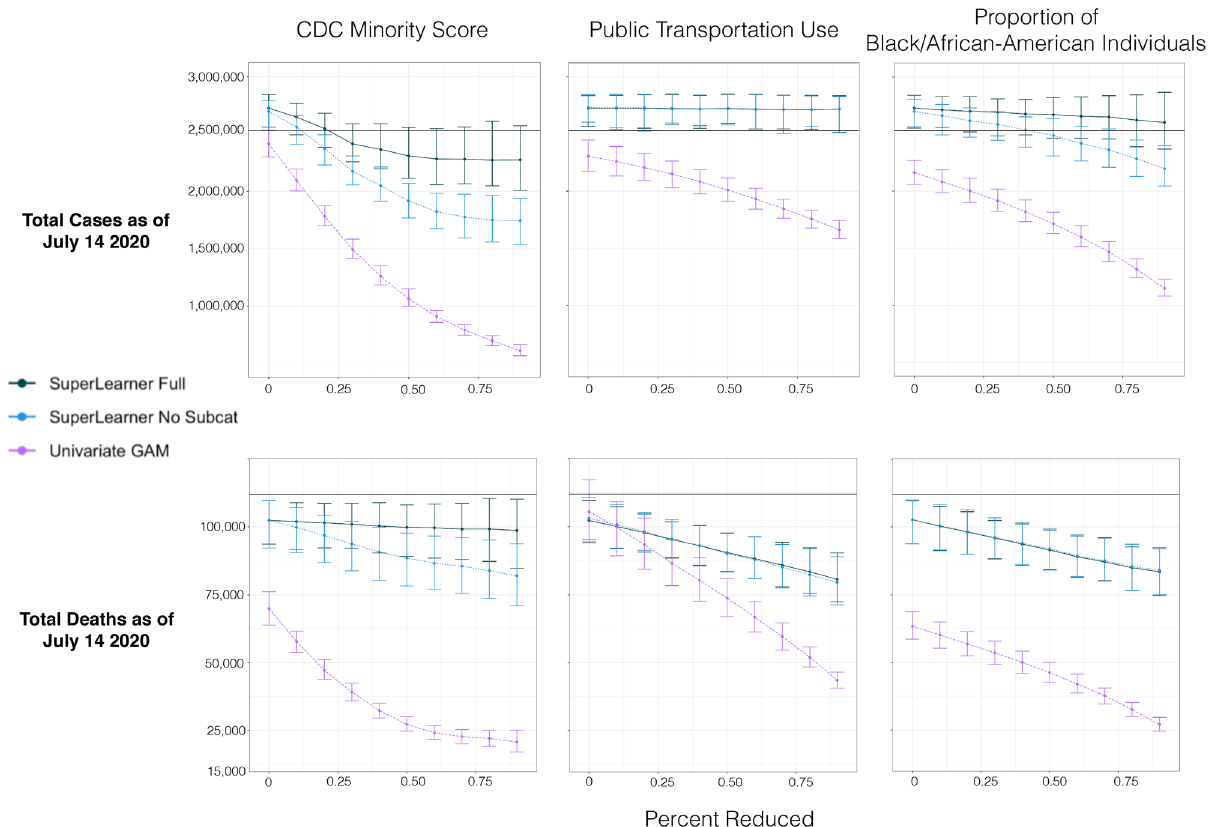
Figure 5. Marginal predictions of total cases and deaths by July 14, 2020) for three of the most consistently important variables in predicting the count outcomes: CDC minority score, proportion of Black- and/or African-Americans and a metric of public transportation use. X-axis is different proportional reductions of each of the three predictors, the Y-axis is the marginal predicted total counts for models adjusting for all other covariates, only covariates not in sub-category (see supplement table S1) and unadjusted. Black lines indicate actual total number of COVID-19 cases and